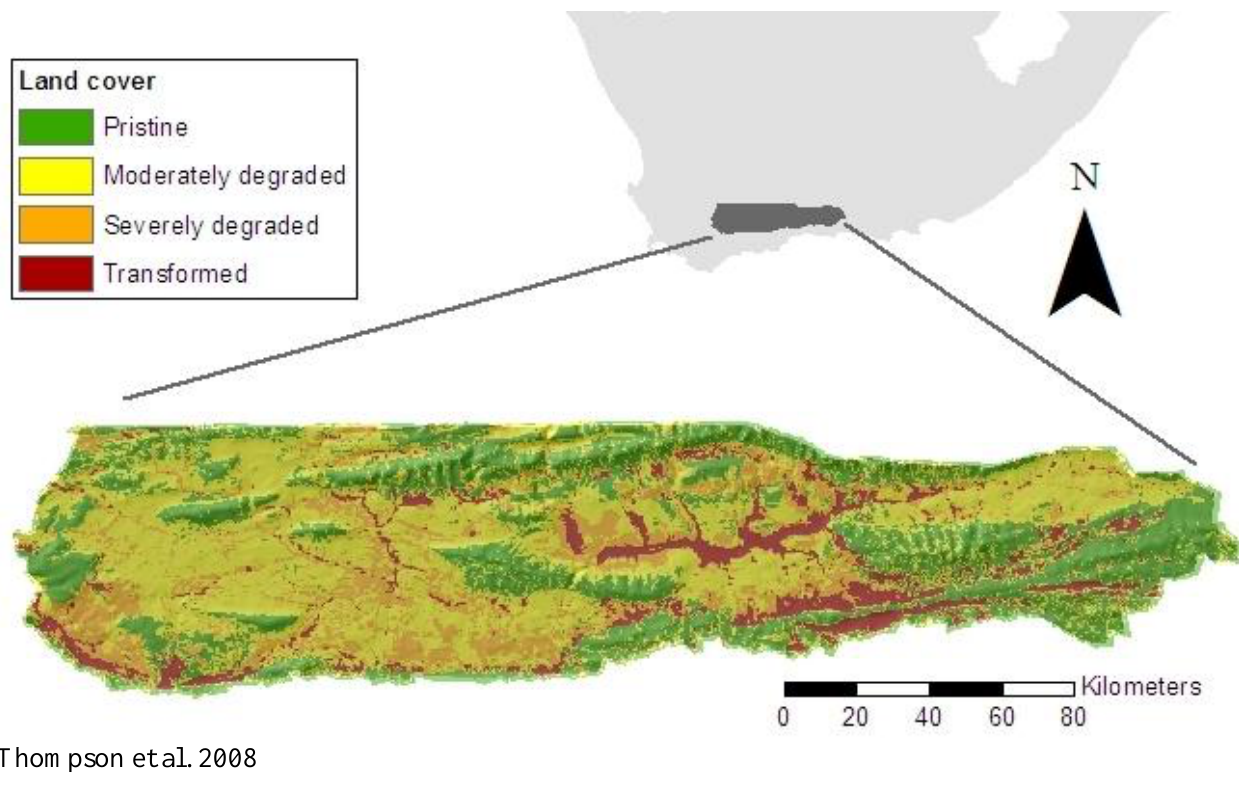
Figure 1. Study area of the Little Karoo illustrating its position in South Africa, as well as the current land-cover